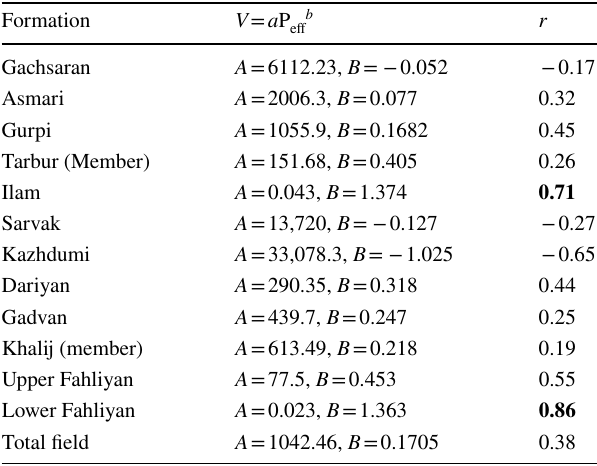
P eff Effective Pressure, r correlation